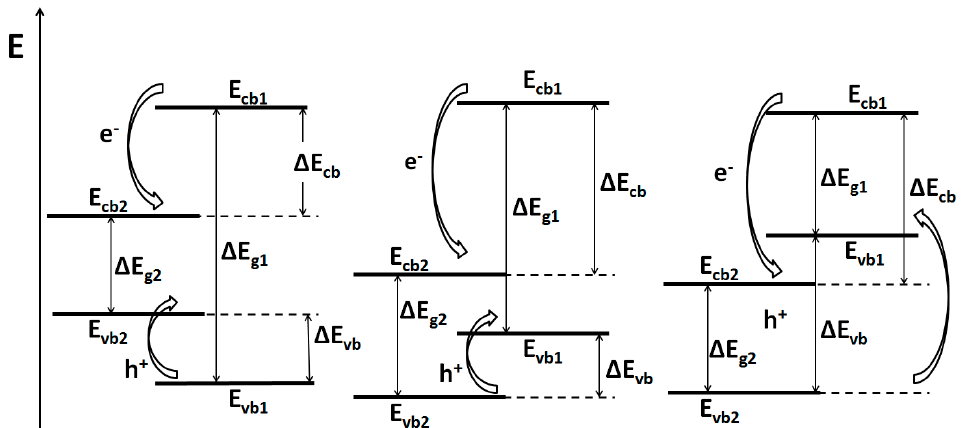
Figure 5. Three possible configurations of n-p heterojunctions.